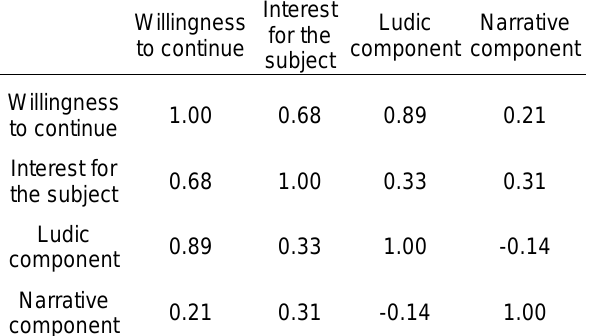
Table 1. Correlation matrix